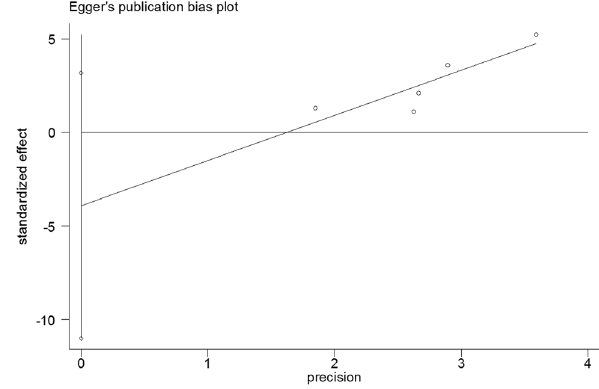
Figure 6: Egger linear regression test for OS in patients exposed to antibiotics versus those not exposed to antibiotics at the initiation of nivolumab treatment.